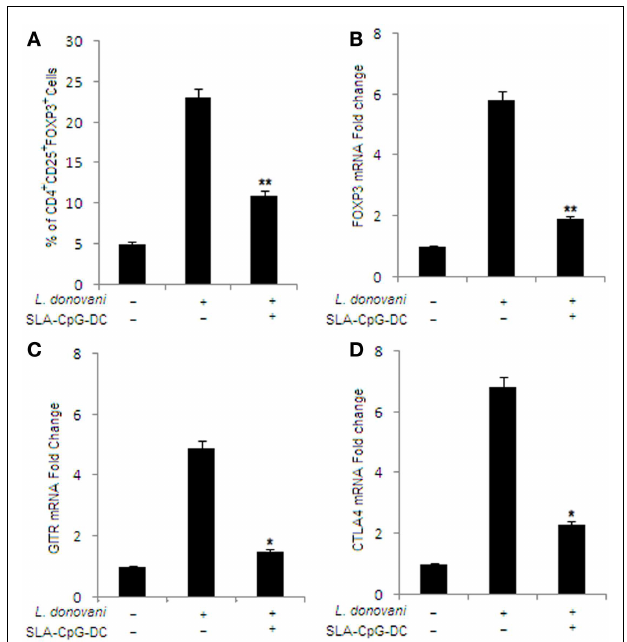
FIGURE 2 | Effect of SLA–CpG–DCs vaccination on the frequency and phenotype ofT regulatory cells . (A) CD4 + T cells (1 × 10 6 ) were purified from infected and indicated treatment groups of mice 28days after infection, plated aseptically followed by fixation and staining forT regulatory cell-specific markers like FITC-conjugated CD25 and PE-conjugated FoxP3 mentioned in Section “Materials and Methods.”The data was analyzed by flow cytometry in each group of untreated and differently treated BALB/c mice have been presented. Data represent the mean ± SD for three animals per group. In a separate experiment, CD4 + CD25 + Treg cells (2 × 10 6 ) were purified from spleen of differently treated mice by MACS as described in Section “Materials and Methods.”These magnetically purified Treg cells were collected inTRIZOL for mRNA extraction and real-time PCR to study mRNA expression ofT regulatory cell markers. Quantitative RT-PCR showing the expression of Foxp3 (B) , GITR (C) , and CTLA4 mRNA (D) , where the data were presented as changes ( n -fold) from uninfected control cells. * P < 0.05 and ** P < 0.001, compared withT regulatory cells isolated from infected mice.The data represent the mean ± SD of data from three independent experiments, which yielded similar results.